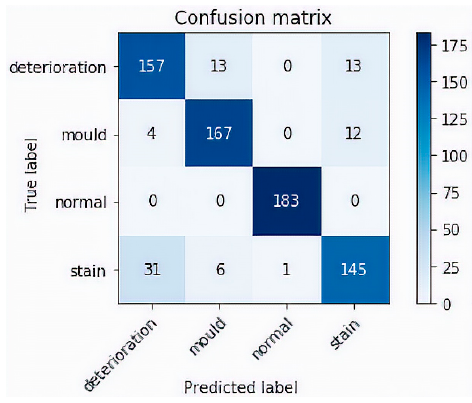
Figure 8. Confusion Matrix. Table 1. Classification Report.